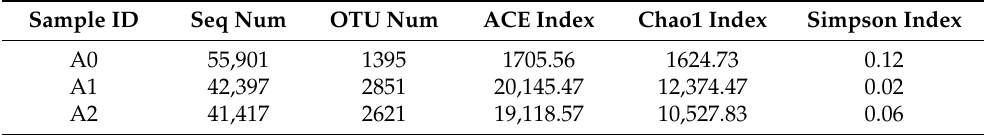
Table 2. The diversity index of the